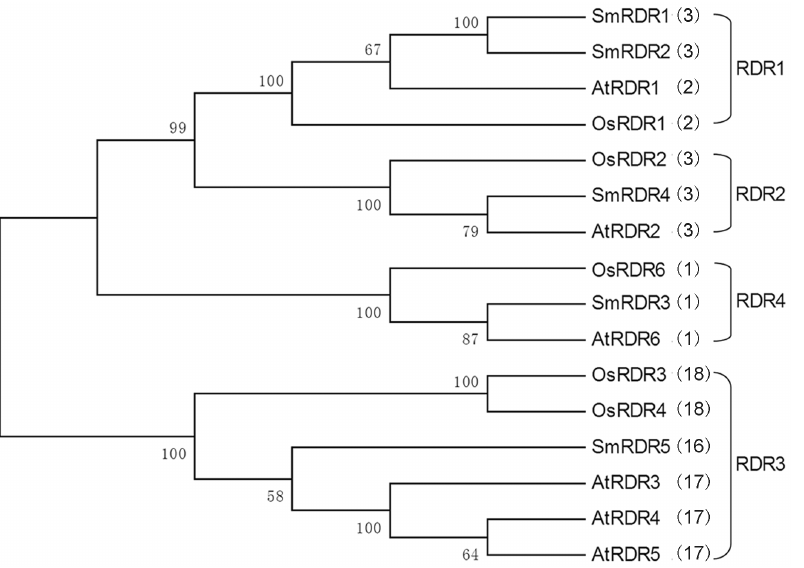
Figure 5. Phylogenetic relationships of sixteen RDRs from S.miltiorrhiza , Arabidopsis and rice. The relationships were analyzed for deduced full-length amino acid sequences using MEGA 4.0 by the neighbor-joining (NJ) method with 1000 bootstrap replicates. Bootstrap values are shown near the nodes. Four groups of RDRs, termed RDR1, RDR2, RDR3 and RDR4, respectively, are indicated. The number of introns in open reading frame (ORF) of the corresponding RDR gene is shown in